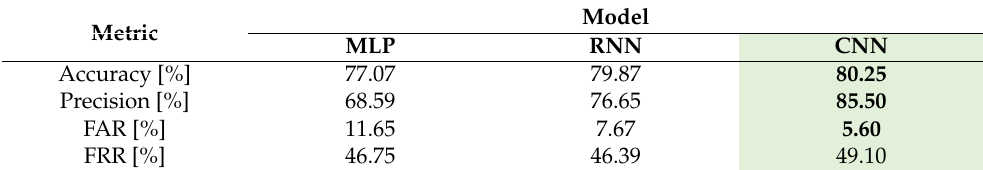
Table 1. VAD frame-level cross-validation performance vs. model type–CENSREC-1-C subset B1.